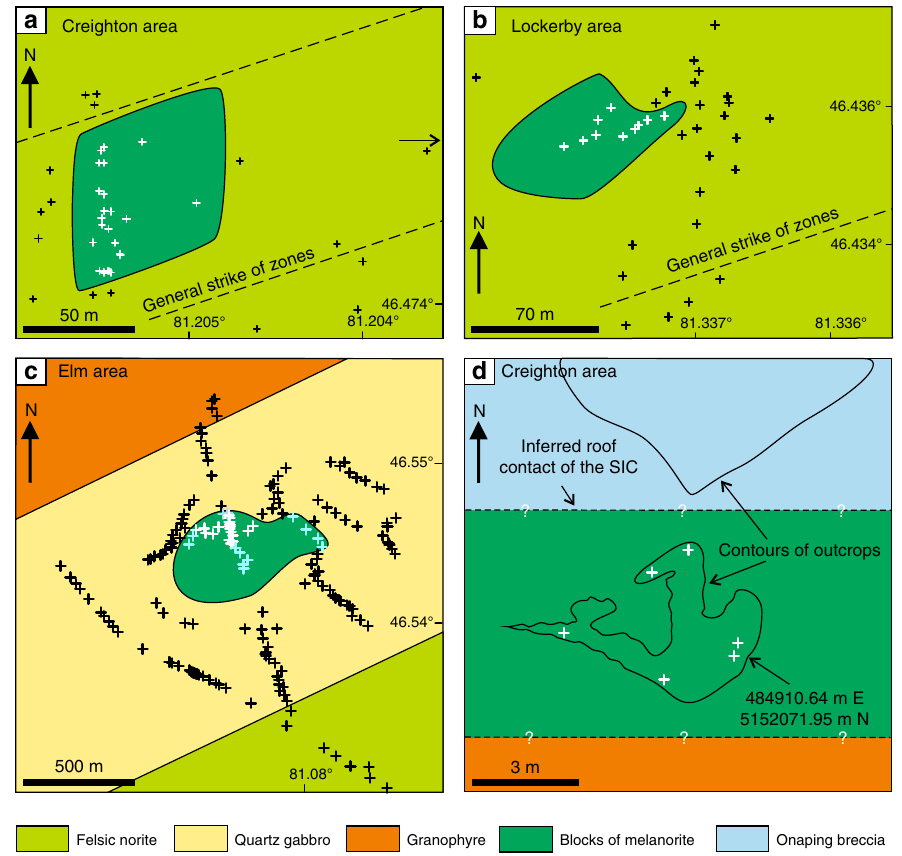
Fig. 2 Schematic maps showing melanorite bodies in the South Range of the SIC. a A medium-sized melanorite body hosted by felsic norites in the Creighton area. b A medium-sized melanorite body hosted by felsic norites in the Lockerby area. c The largest melanorite body hosted by quartz gabbro in the Elm area. d Outcrop of the melanorite along the roof of the SIC in the Creighton area (mapped by Walter Peredery, 2017). Samples of the bodies with MgO = 7 – 9 wt.% are indicated by white crosses whereas those with MgO = 5-6 wt.% are indicated by blue crosses; black crosses indicate all host rocks of the SIC. The discrete shape of the bodies in a – c indicates that these are separate blocks rather than (semi)continuous layers in the stratigraphy of the